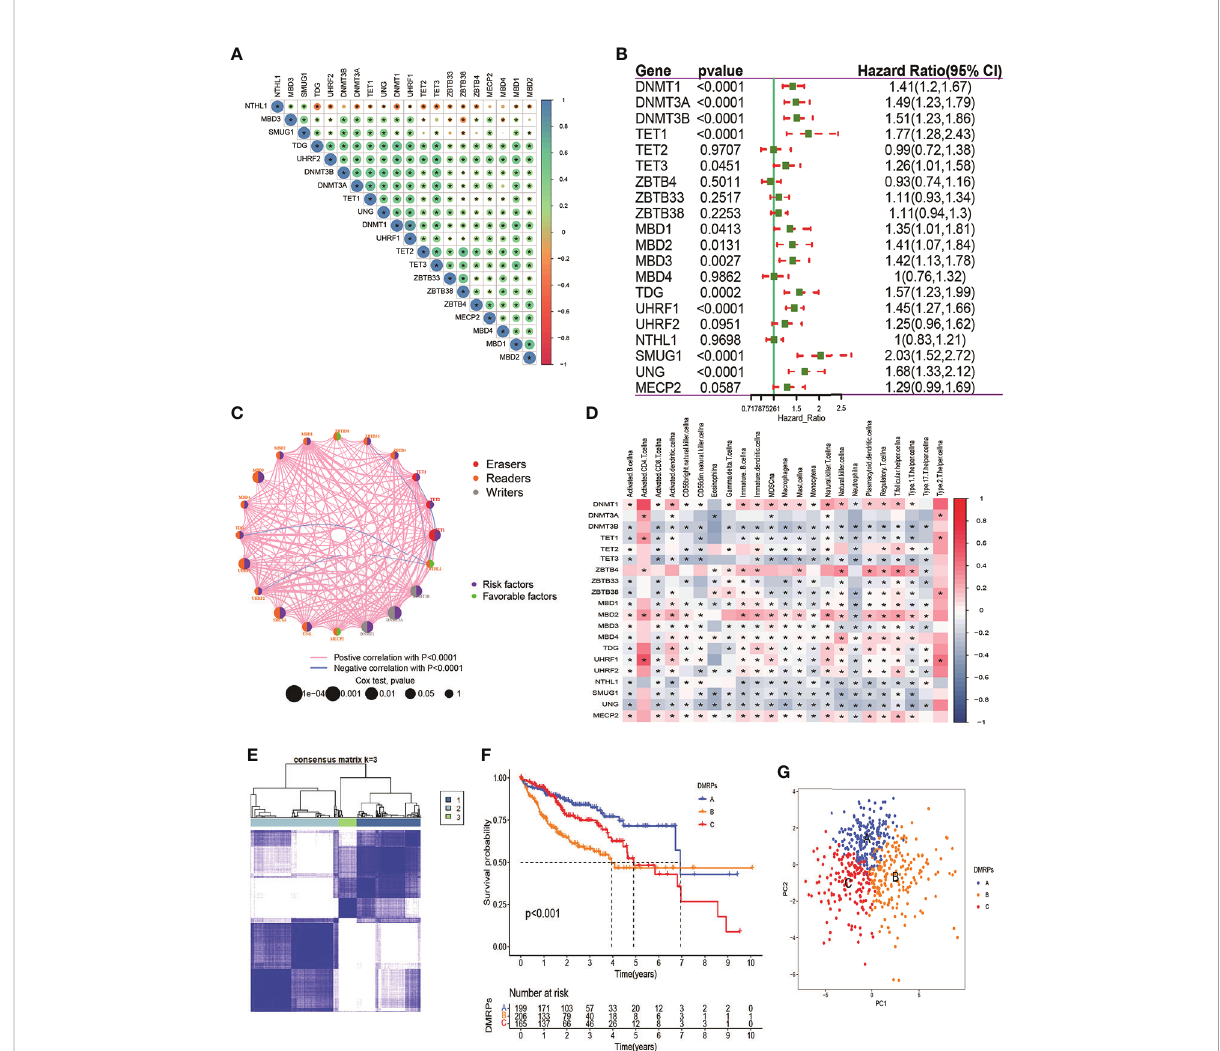
FIGURE 2 Prognosis of DNA methylation regulators and patterns of DNA methylation regulators modi fi cation. (A) The correlation of 20 DNA methylation regulators in HCC patients. (B) The prognosis of 20 DNA methylation regulators in HCC patients. (C) The interaction among 20 DNA methylation regulators in HCC. The pink and blue line represents positive and negative correlation. The size of the circle represents the p value of the log-rank test. Green points represent favorable factors for OS. Purple points represent risk factors for OS. (D) The correlation between 20 DNA methylation regulators and 23 types of immune cells. (E) The consensus cluster matrix for patients with HCC. (F) The survival analysis for different patterns of patients. (G) PCA analysis indicated signi fi cant separation among three patterns. * p <